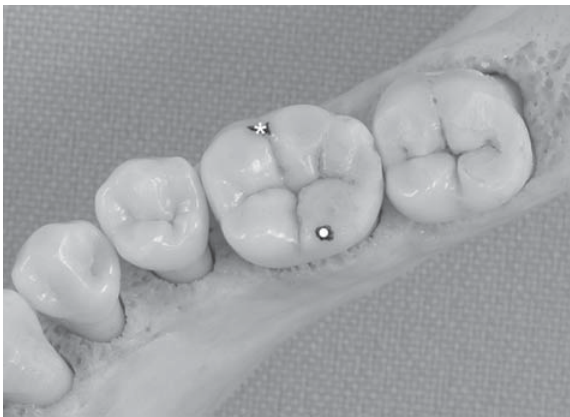
Figure 1- Occlusal surface of the mandibular